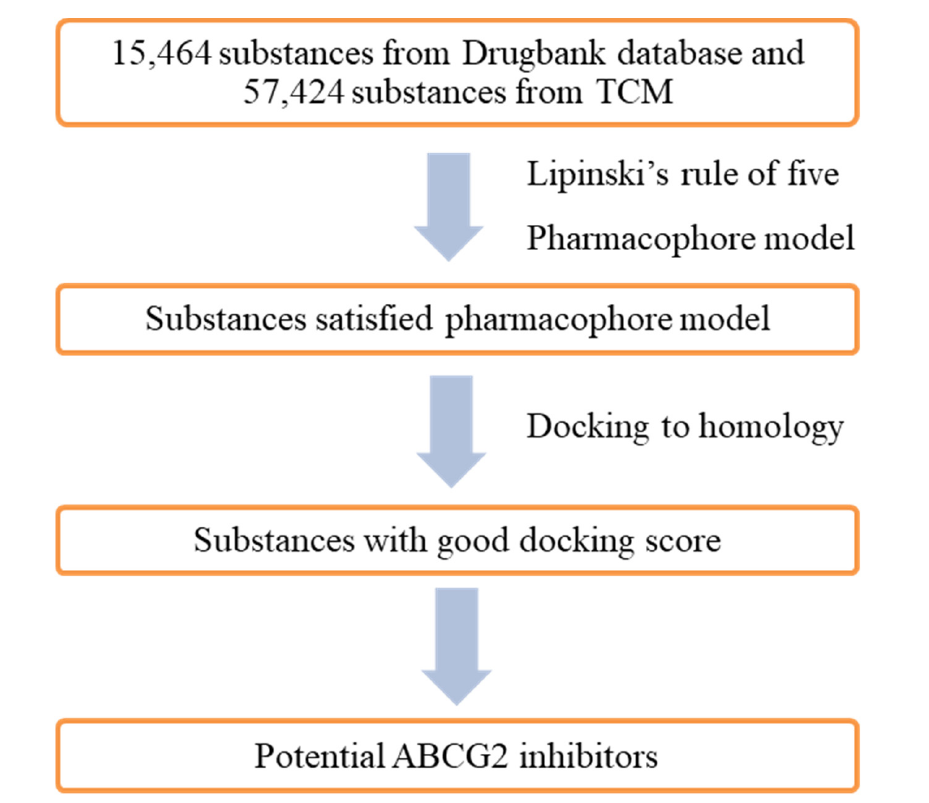
Figure 18. Virtual screening process for ABCG2 inhibitors.